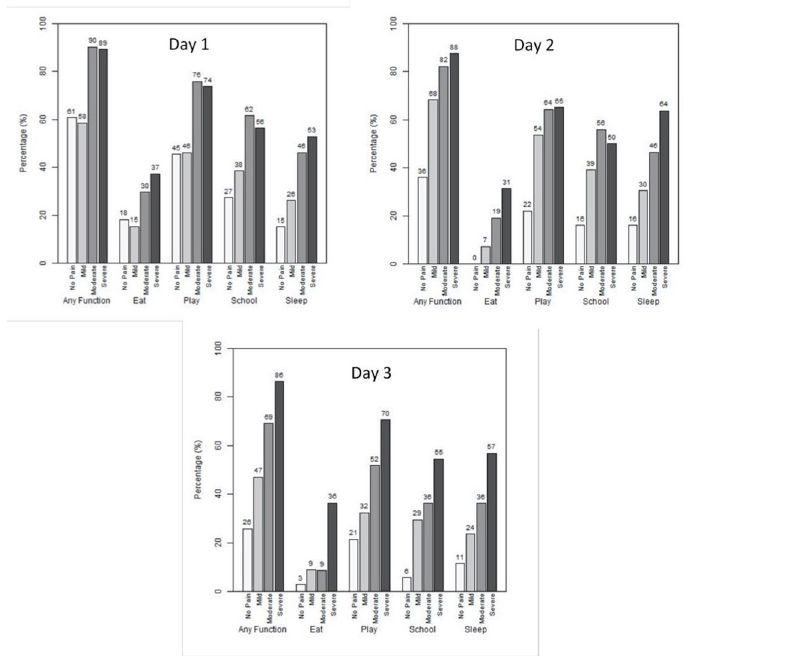
Fig 3. Function affected vs. pain severity (n = 329).